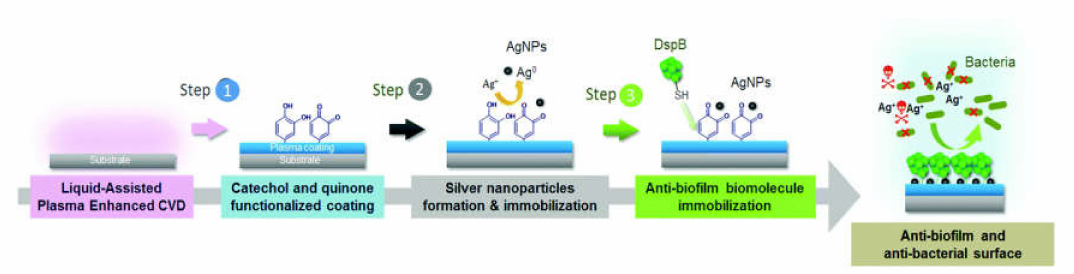
Figure 9. Schematic illustration of the elaboration of multifunctional surfaces achieved via aerosol-assisted PE-CVD of a catechol-quinone functionalized coating for co-immobilizing Ag NPs and biomolecules. Reprinted with permission from [65]. Copyright 20018 Royal Society of Chemistry.